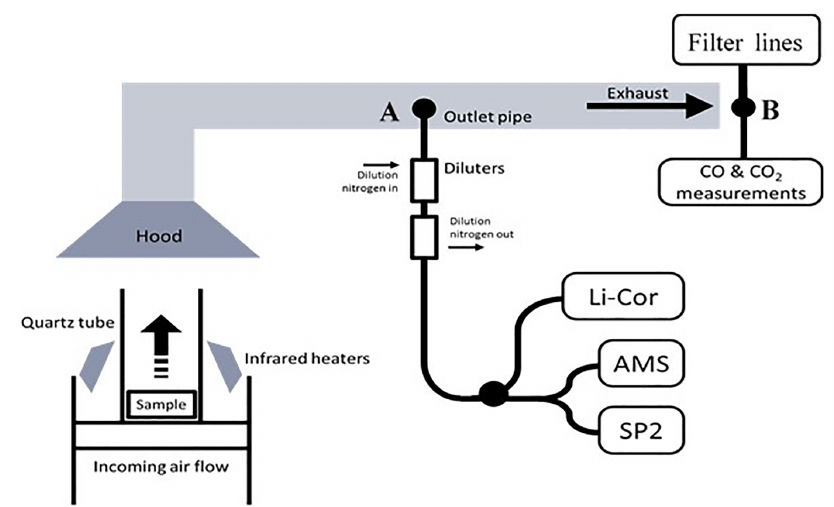
Figure 3. Schematic view of the FM-Global Fire Propagation Apparatus with a diagram of the gas and particle sampling system (adapted from Haslett et al.,